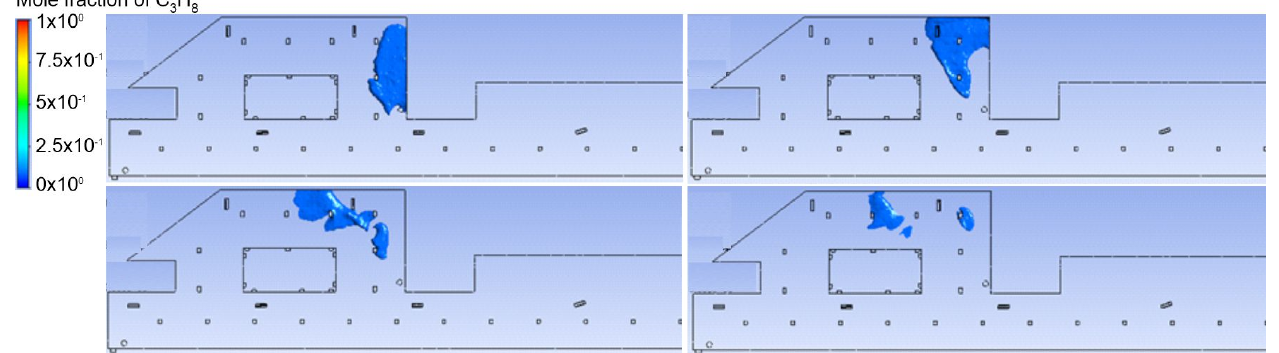
Figure 16. Lower explosive limit of LPG distribution in an underground garage after gas dispersion for B source for different time steps of 15 s, 35 s, 55 s and 70 s.